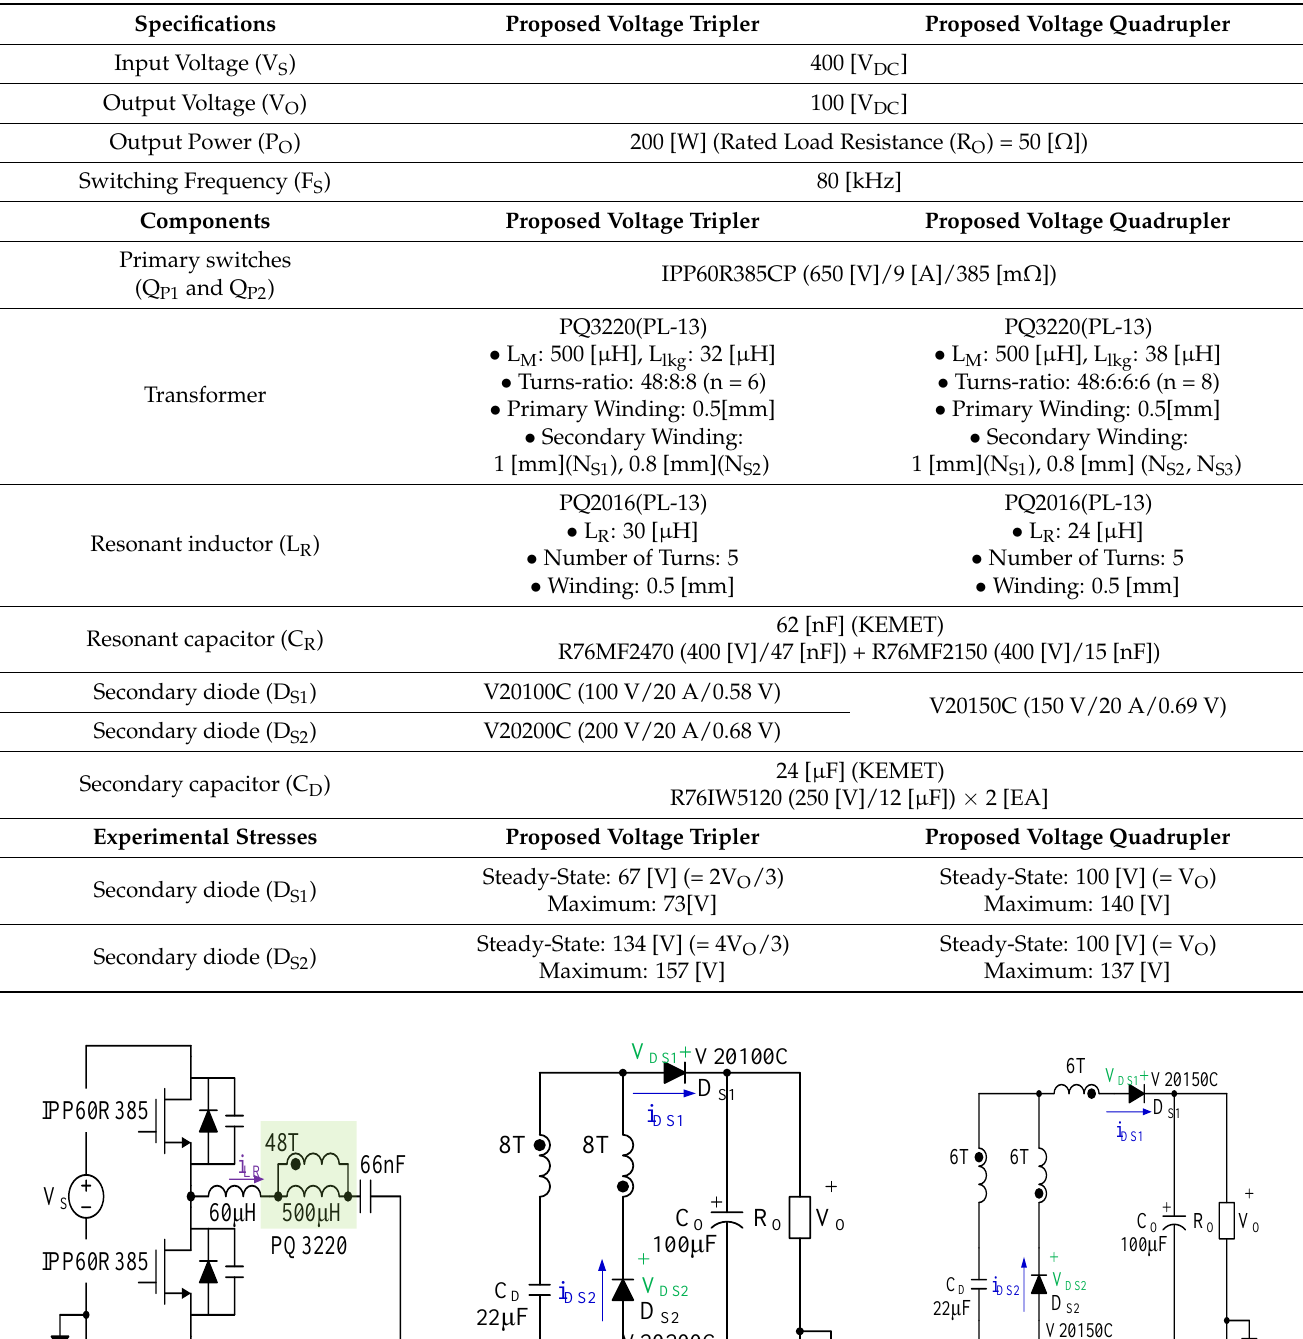
Table 5. Specifications and components used in experimental prototype.